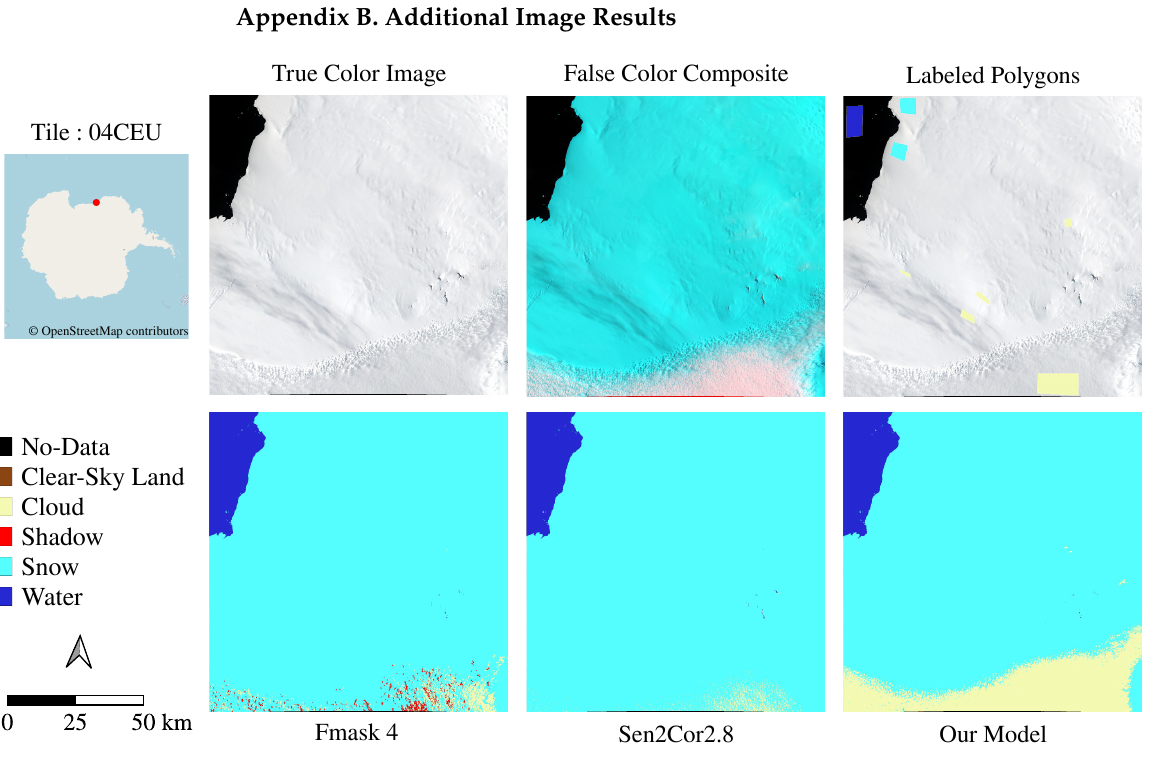
Figure A1. Comparison of test image results from Tile 04CEU in Marie Byrd Land,